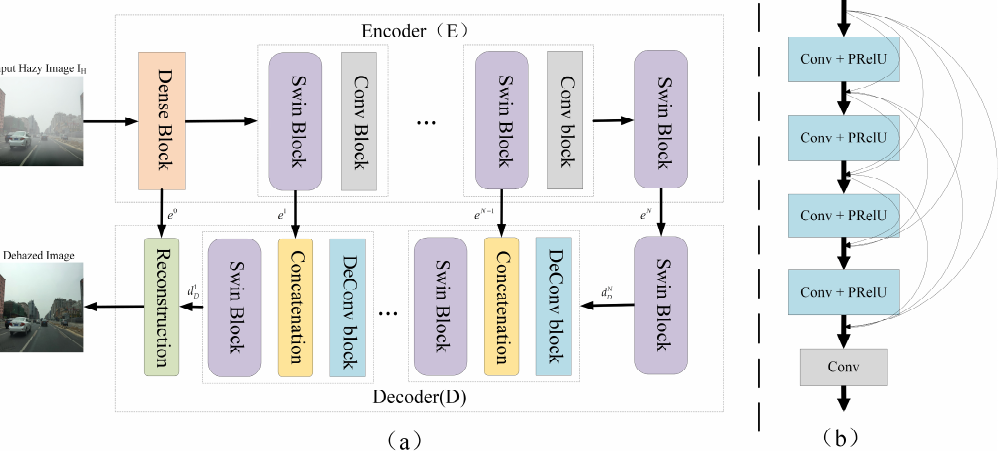
Figure 2. The architecture of dehazing network. ( a ) The overall dehazing network, which consists of an encoder and decoder. ( b ) The architecture of dense block.